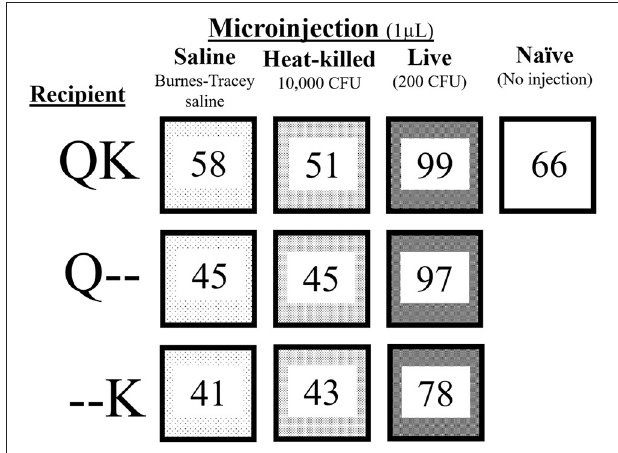
FIGURE 2 | Experimental design. The numbers in each box represent the number of incipient colonies initially set up for each treatment: kings (K) and/or queens (Q) were treated with one of the treatments (saline, HK- Sm , Live- Sm ). QK indicates both reproductives were treated while Q-- and --K designate the member of the pair who received the treatment while its mate remained naïve (--). This scheme resulted in 9 treatment combinations. A tenth treatment had both kings and queens untreated (naïve) to provide a baseline of normal colony fitness parameters during the first 30